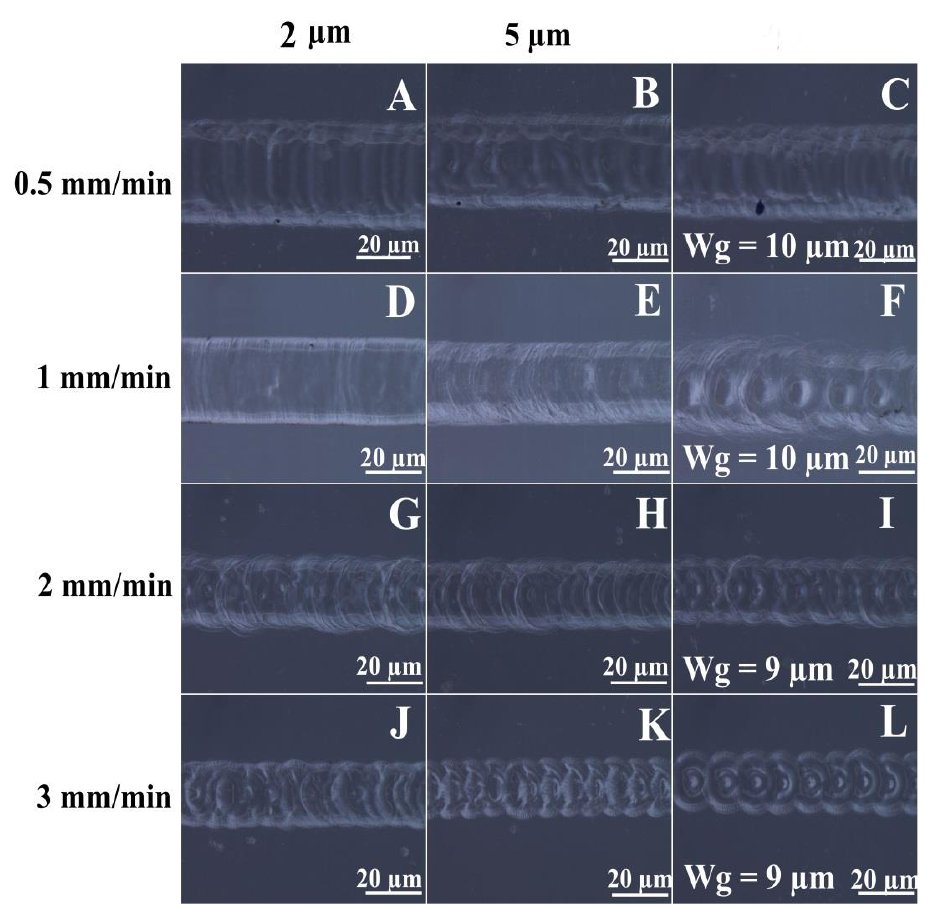
Figure 5. Optical images of micro-channels fabricated at 33 V using 30% NaOH at different tool travel rates and working gaps .